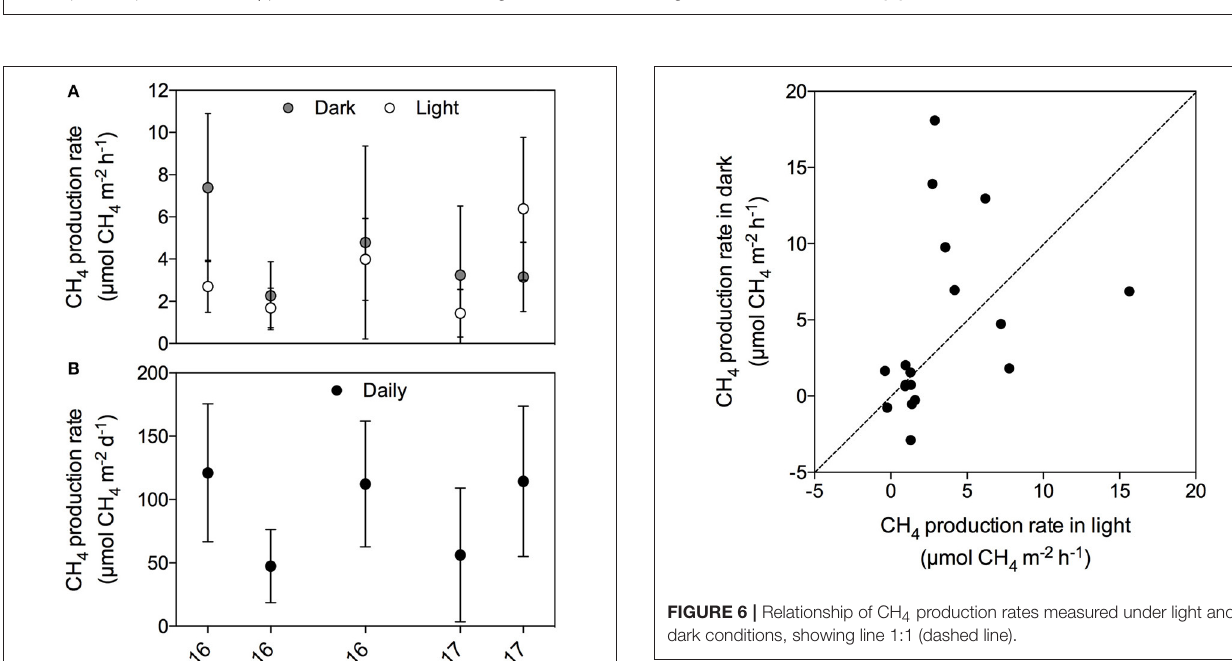
with minimum values coinciding with maximum oxygen levels night in an intertidal Zostera noltii meadow (Bahlmann et al.,